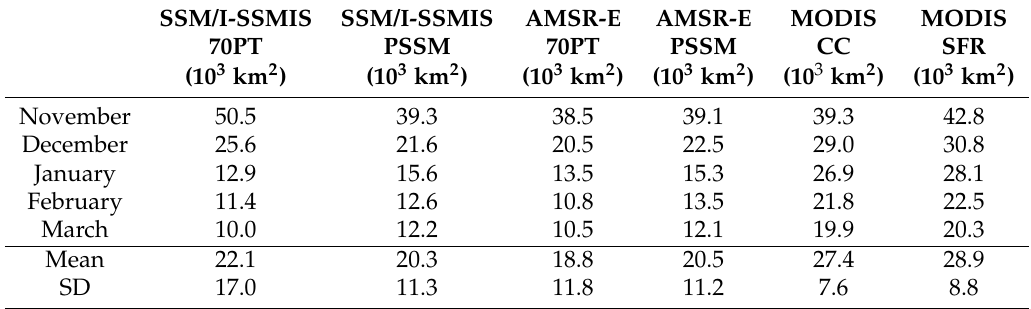
Table 3. Comparison of calculated monthly mean polynya area (POLA; in 10 3 km 2 ) from different sensor types (SSM/I-SSMIS, AMSR-E, MODIS) and methods, averaged over the overlapping period from 2002/2003 to 2010/2011 (November to March). Cloud-cover corrections have been applied to the MODIS data where CC denotes the values after coverage correction and SFR denotes the values after the spatial feature reconstruction (compare Section 2.6). All values are calculated within the predefined polynya mask (Figure 1).